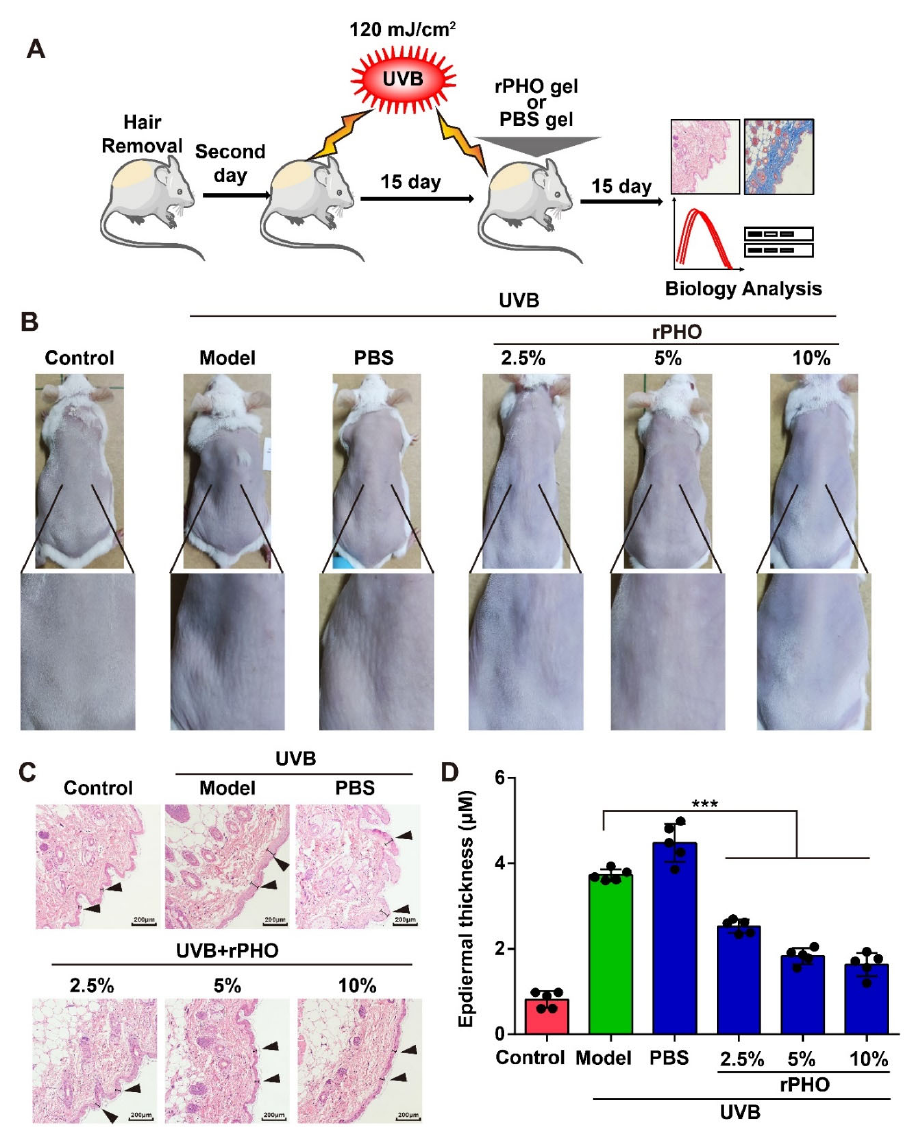
Figure 4. rPHO prevented UVB ‐ induced photoaging in mice. ( A ) Schematic diagram of UVB irradiation and rPHO administration. ( B ) Representative images of the morphological changes of the dorsal skin in each group after rPHO treatment for 15 days. ( C ) Representative images of HE staining after rPHO treatment for 15 days. Scale bar = 100 μ m. ( D ) The thickness of the epidermis was measured using ImageJ. Data are presented as means ± SD ( n = 5). *** p < 0.001.